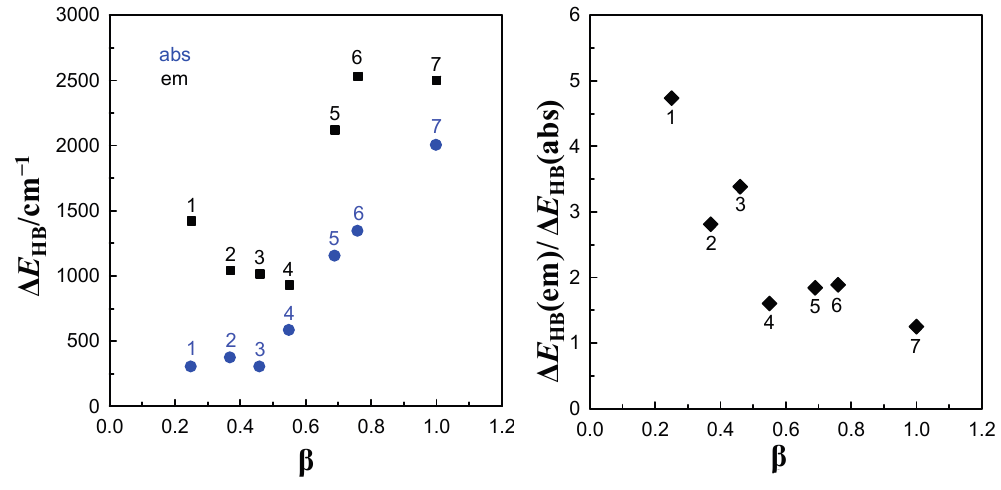
Figure 4. Correlation between the hydrogen bond energy changes, ∆ E HB , as a result of absorption or emission process and the solvent Kamlet-Taft’s hydrogen-bonding accepting parameter, β , for 6AC-(solvent) n , n = 1, 2, complexes: (1) acrylonitrile, (2)